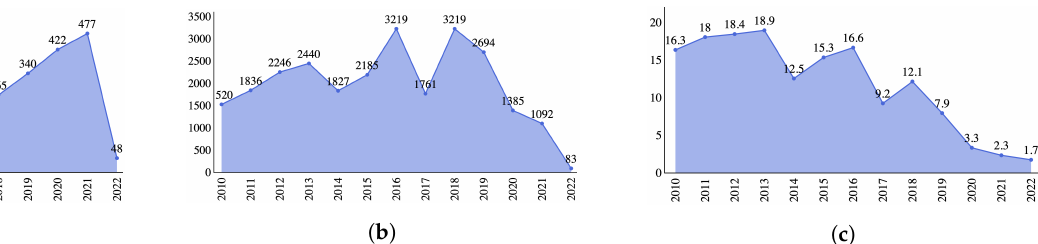
Figure 2. Line charts (filtered documents). ( a ) Total number of documents per year. ( b ) Total number of citations per year. ( c ) Average number of citations per year.